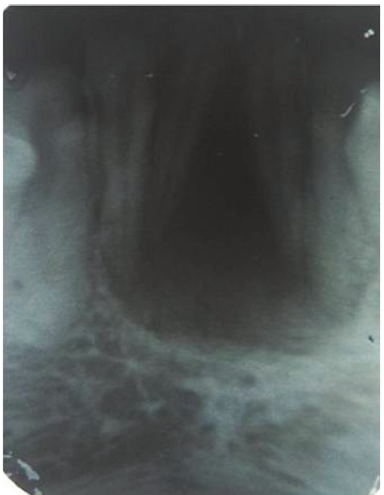
Figure 1: Intraoral periapical radiograph reveals triangular radiolu- cent area involving roots of mandibular central incisors.